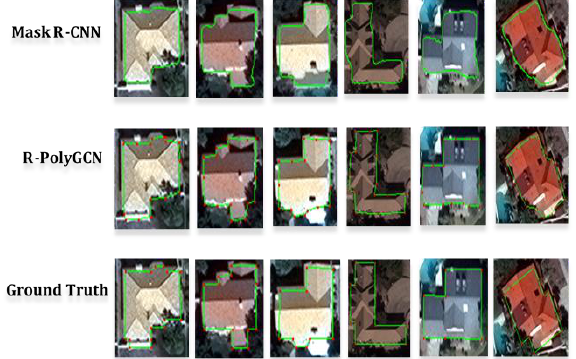
Figure 5: Comparison of the performance of building boundary